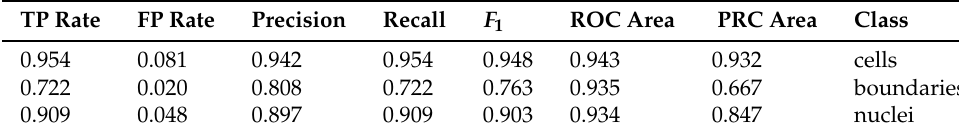
Table 8. SMO learning performance in 3 class segmentation